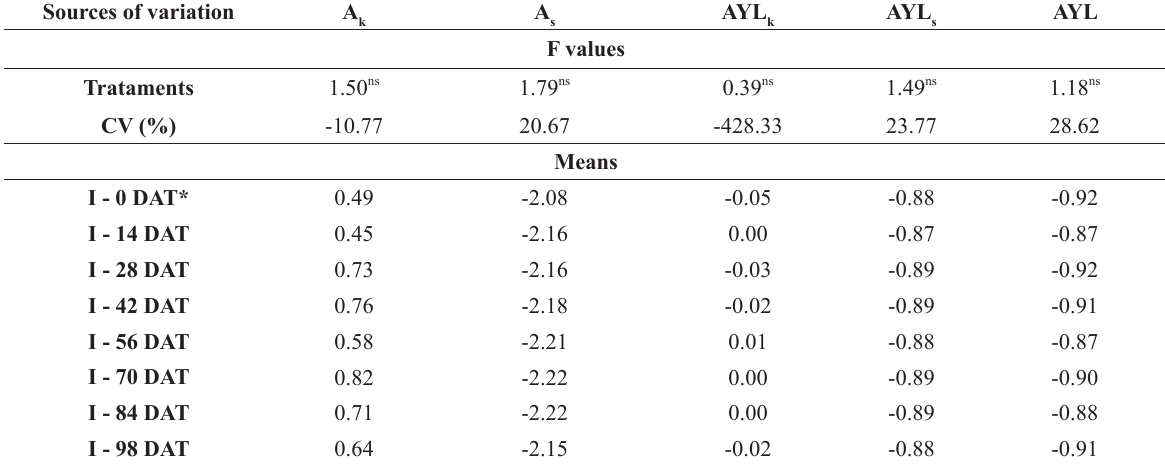
Summary of the variance analysis (F values, coefficients of variation and means) for kale aggressiveness (A Zealand spinach aggressiveness (A yield loss of intercropping (AYL) as function of the time of transplanting of the New Zealand spinach in relation to the